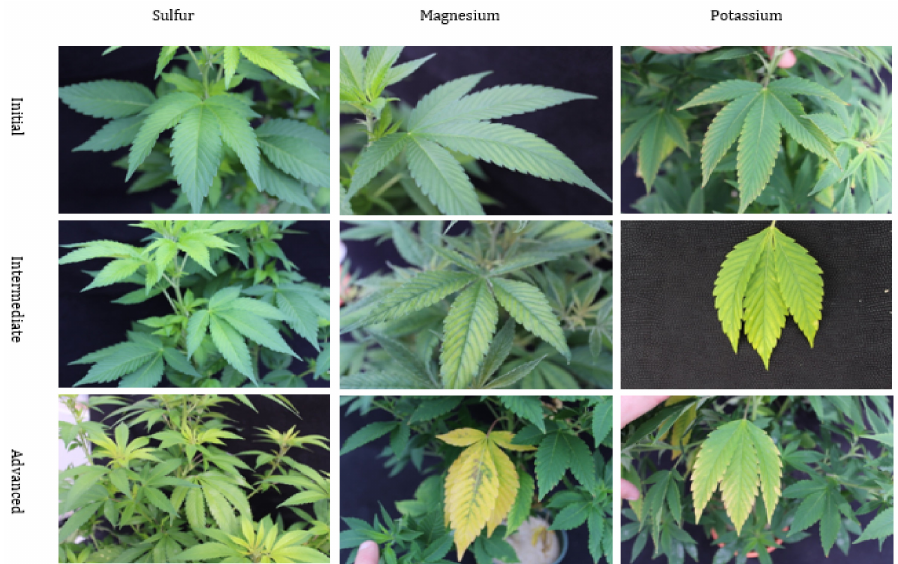
Figure 3. Nutritional disorders of sulfur (S), magnesium (Mg), and potassium (K) deficiency in Cannabis sativa ‘T1’ plants. These pictures display the symptomological progression of nutritional orders as they progress from initial, intermediate, and